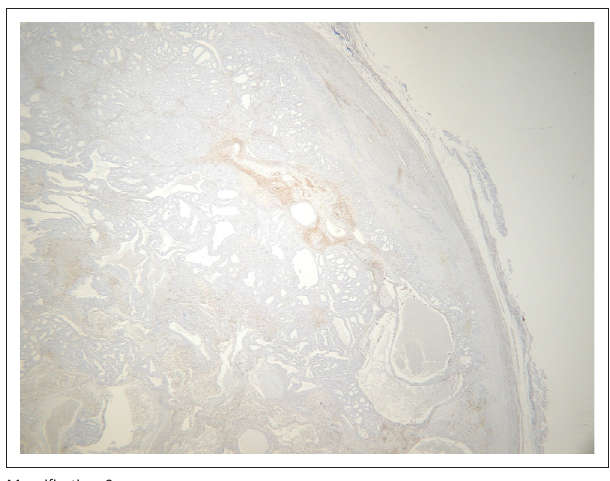
Magnification: 2×. FIGURE 1: Micrograph of the thyroid carcino-sarcoma stained with vimentin.